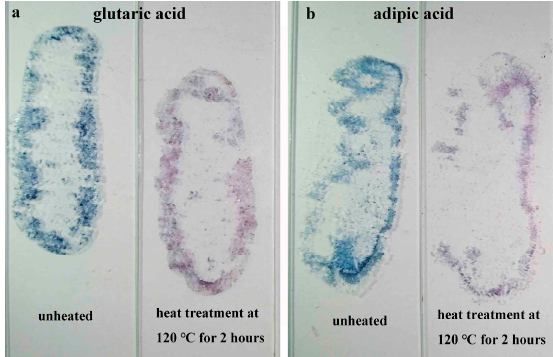
Figure 13. Digital image of PBI-1 aggregates, r = 500:1.